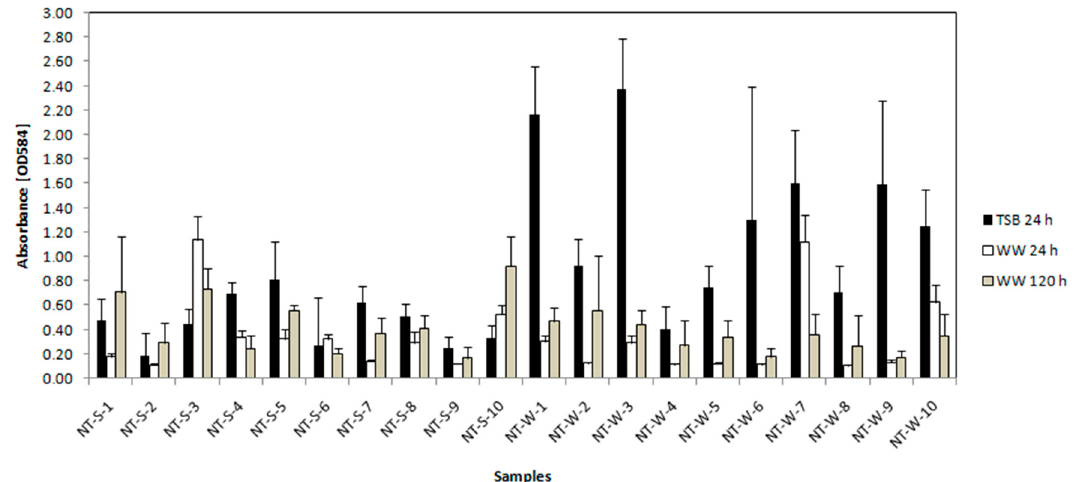
Figure 2. Biofilm formation of isolates from the nitrification tank of wastewater treatment plant incubated in tryptic soy broth (TSB) and nitrification wastewater (WW). Bacterial biofilm measured at 584 nm after 24-h and 120-h incubation at 30 °C.